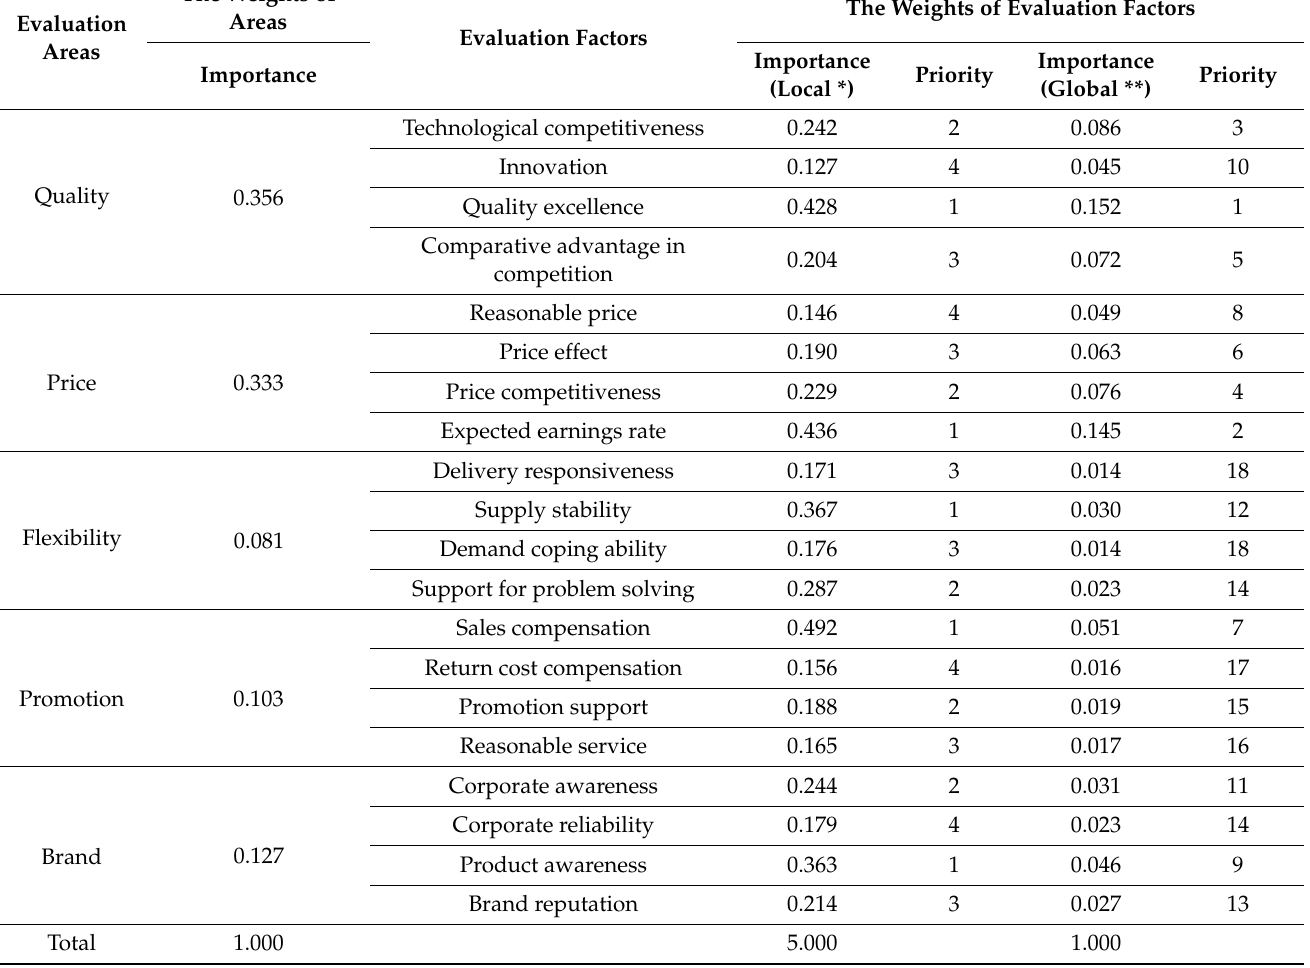
Table 4. Weights and priority of evaluation